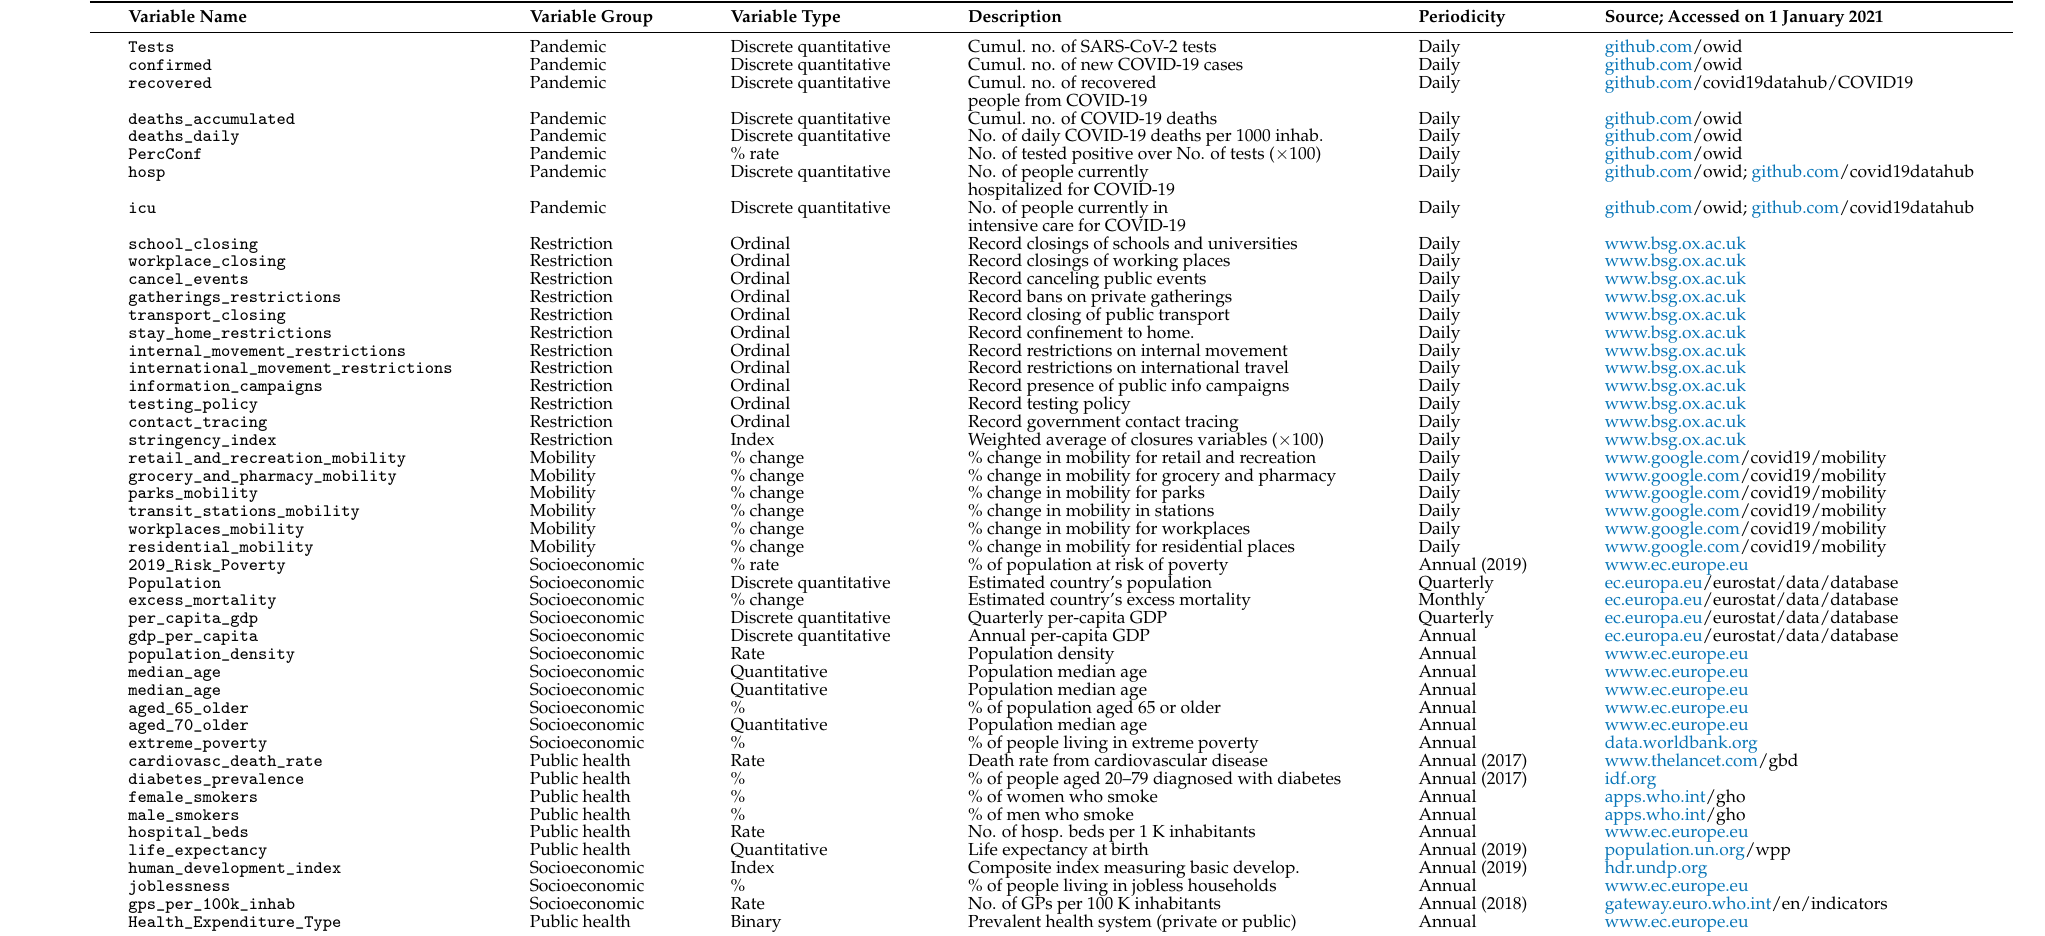
Table A1. Variable description and sources—Variable values are referred to the period 24 February 2020–30 November 2020, unless stated